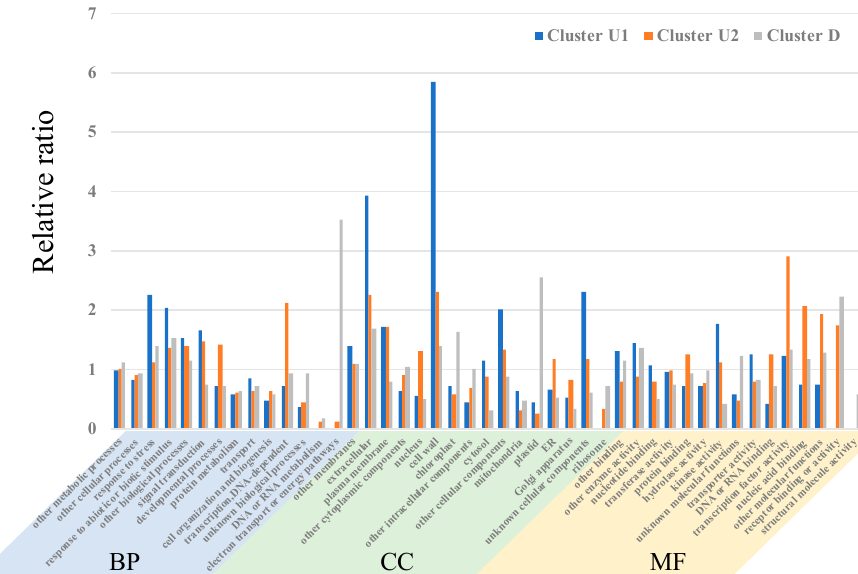
Figure 3. Gene ontology (GO) categories of DEGs that encoded proteins with sequence similarity (E-value < 1E − 5) to proteins in the TAIR database. The longitudinal axis shows the relative ratio of the genes of Cluster U1 (blue), U2 (orange), and D (gray) against GO analysis results for all genes on the custom microarray (GEO accession: GPL21366). BP: biological process, CC: cellular component, MF: molecular function.